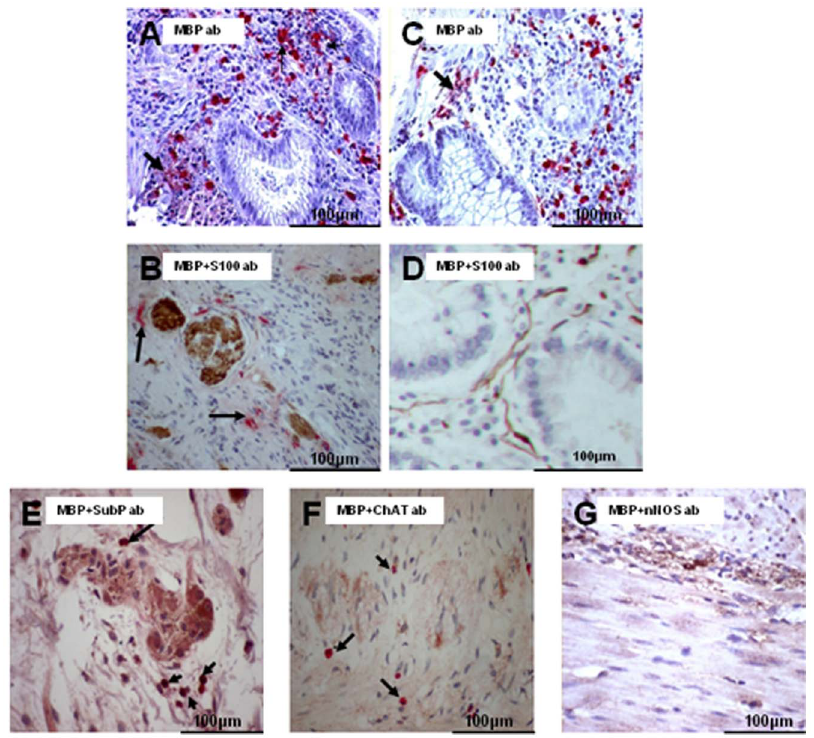
Figure 4. Eosinophil phenotype and nerve subspecies in IBD. There is a considerable eosinophil accumulation and deposition of extra-cellular MBP in patients with therapeutically responsive IBD. Photomicrographs (A and B) are representative sections from patients with clinically active responsive UC and arrowed areas demonstrate extracellular MBP. Photomicrograph (B) is also immune-stained with anti-S100 to demonstrate neural tissue. Photomicrograph (C) is taken from a patient with clinically quiescent therapeutically responsive UC. The arrows in photomicrographs (A-C) illustrate examples extracellular MBP. Note that extracellular MBP deposition is less prominent in the clinically quiescent state. (D) is a representative section from a control patient. Photomicrographs (E) and (F) demonstrate eosinophil co-localization to Substance P and ChAT immunoreactive nerves respectively in patients with IBD. Eosinophils did not co-localize to nNOS immunoreactive nerves (G). The arrows in (E, F) demonstrate MBP stained eosinophils in association with nerve